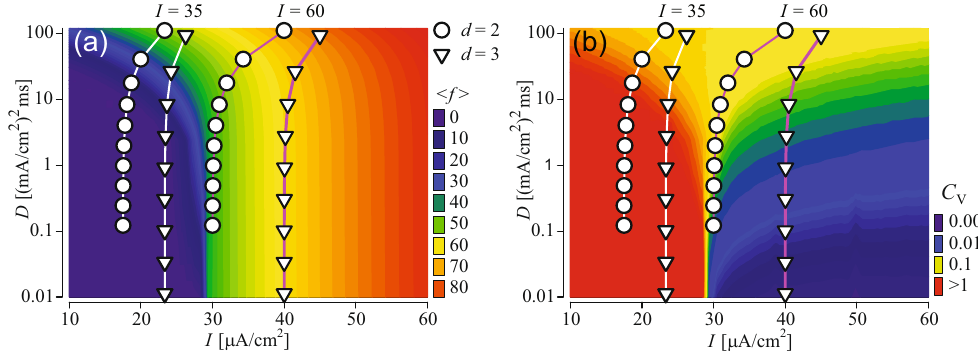
Figure 6. Heat maps of the mean firing rate, 〈 f 〉 ( a ), and coefficient of variation, C V ( b ), vs input current, I , and noise intensity, D , for the single isolated HH node obtained from numerical simulations. Symbols and lines show the scaling of the current, Eq. (24), and noise intensity, Eq. (25), respectively, for tree networks with indicated values of the branching d ( d = 2, circles; d = 3, triangles) and with increasing number of generations, G from 1 (top) to 10 (bottom). These lines correspond to Fig. 5. For tree networks, the input current to the peripheral nodes is I = 35 μ A/cm 2 (white lines) and I = 60 μ A/cm 2 (magenta lines) and the noise intensity is D = 500 ( μ A/cm 2 ) 2